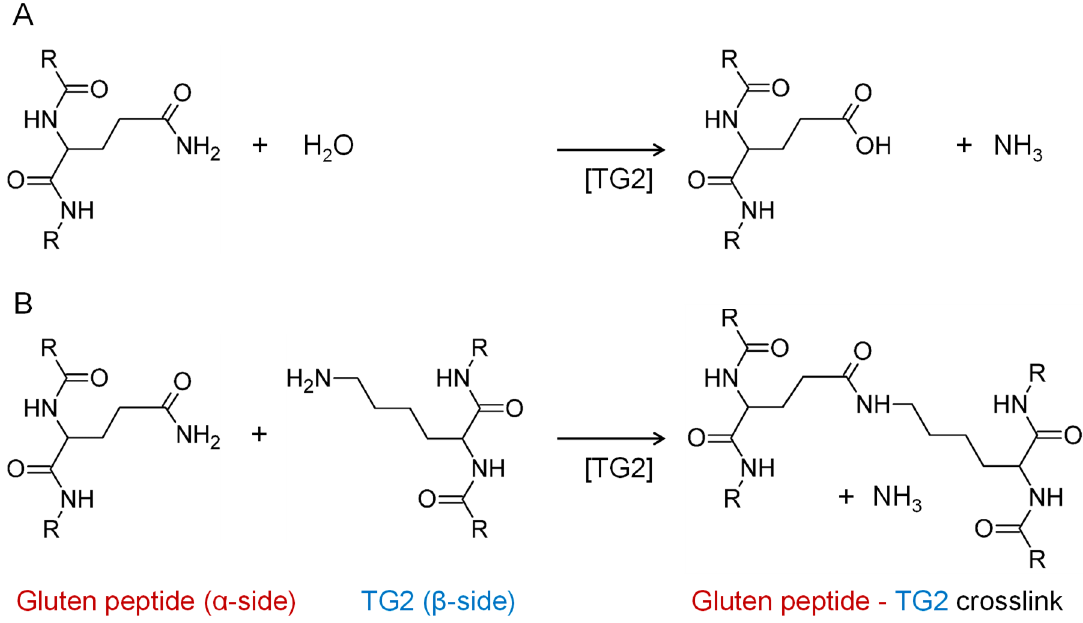
Figure 1. Reactions catalyzed by tissue transglutaminase (TG2). ( A ) Deamidation of glutamine to glutamic acid side chains in the absence of primary amines. ( B ) Crosslinking of glutamine and lysine side chains resulting in the formation of isopeptides.